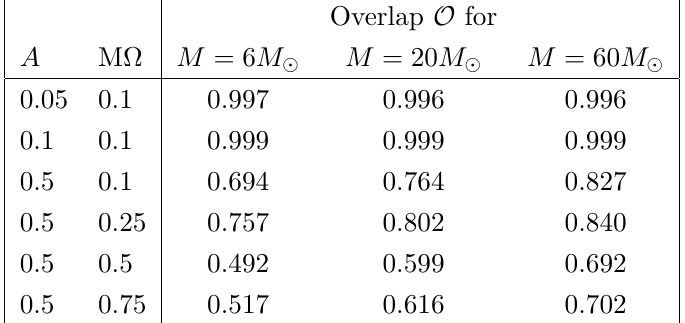
Table 1 . The overlap O between the GR waveform and the perturbed waveforms with amplitudes A and frequencies M (cid:10), computed using eq.